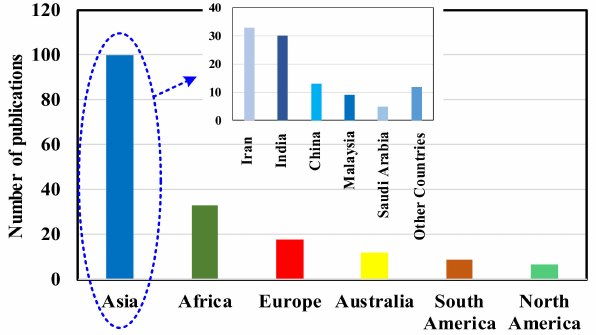
Figure 9. Number of publications per countries for RAES optimal